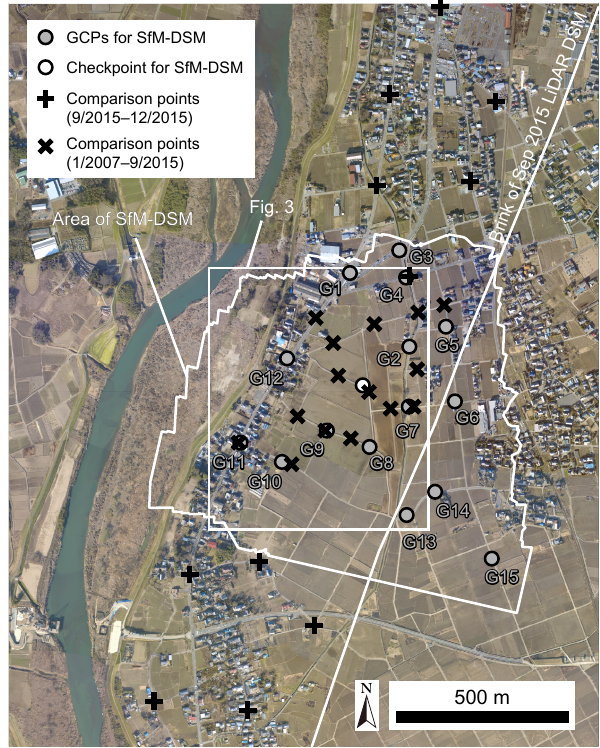
Figure 2. Distributions of GCPs and checkpoints for the SfM- derived DSM and comparison points for each DSM subtraction